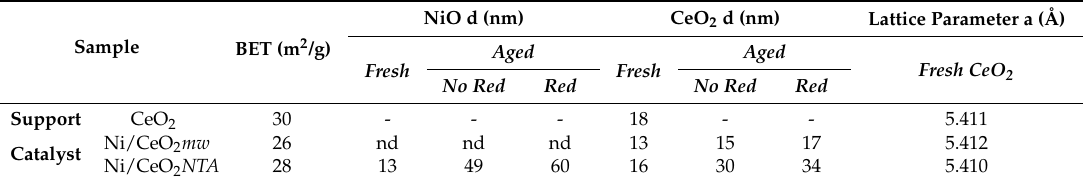
Table 1. Specific surface area (BET), NiO, and CeO 2 crystallite sizes (d) a and CeO 2 lattice parameter (a) b